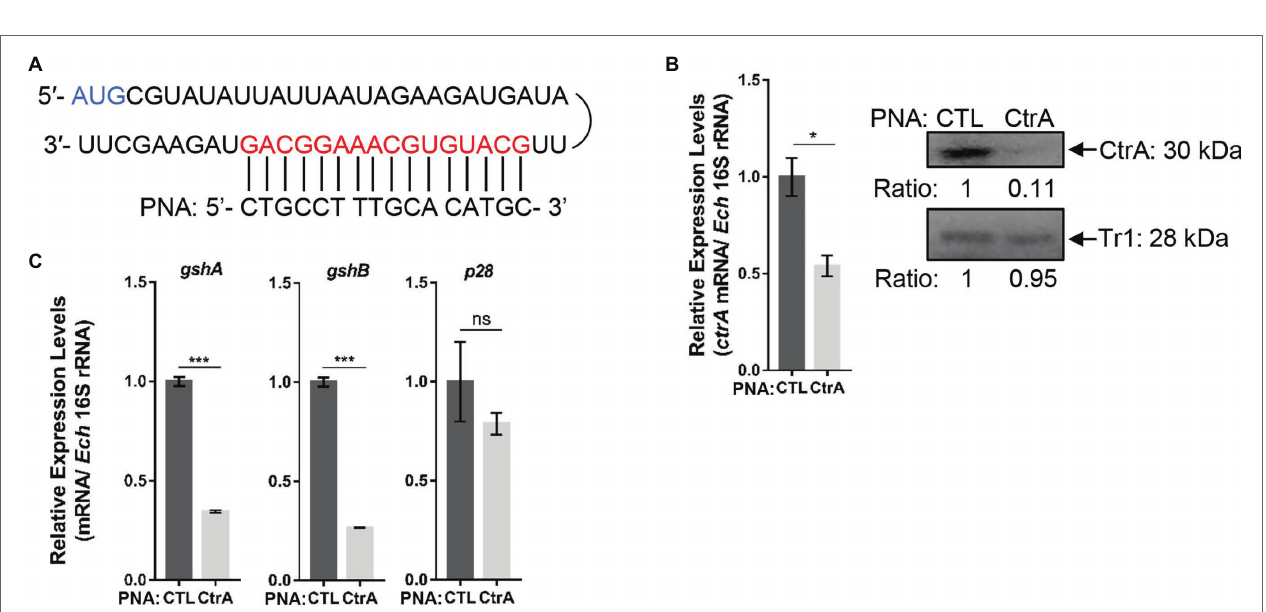
FIGURE 4 | CtrA peptide nucleic acid (PNA) transfection inhibits the expression of ctrA , gshA , and gshB. (A) CtrA PNA targets the ctrA mRNA. The mRNA sequence of ctrA from the translation start codon (AUG) and the CtrA PNA sequence are shown. (B) CtrA PNA significantly reduces E. chaffeensis ctrA mRNA and CtrA protein levels. The ctrA mRNA levels were determined with qRT-PCR and normalized against those of E. chaffeensis 16S rRNA (left). Relative values to the amount of CTL PNA- transfected E. chaffeensis are shown. Data indicate means ± standard deviations ( n = 3). The significant differences are represented by p -values determined with Student’s t -test (* p < 0.05). The protein levels of CtrA or Tr1 (negative control) were determined with Western blotting (right). The numbers below the panels indicate the relative intensity of each protein band. The protein level of CTL PNA-transfected E. chaffeensis is set as 1. (C) CtrA PNA significantly reduces the expression of gshA and gshB . The expression levels of gshA , gshB , and p28 were determined with qRT-PCR and normalized against those of bacteria 16S rRNA. Relative values to the amount of CTL PNA-transfected E. chaffeensis are shown. Data indicate means ± standard deviations ( n = 3). The significant differences are represented by p -values determined with Student’s t -test (ns indicates p > 0.05, *** p <